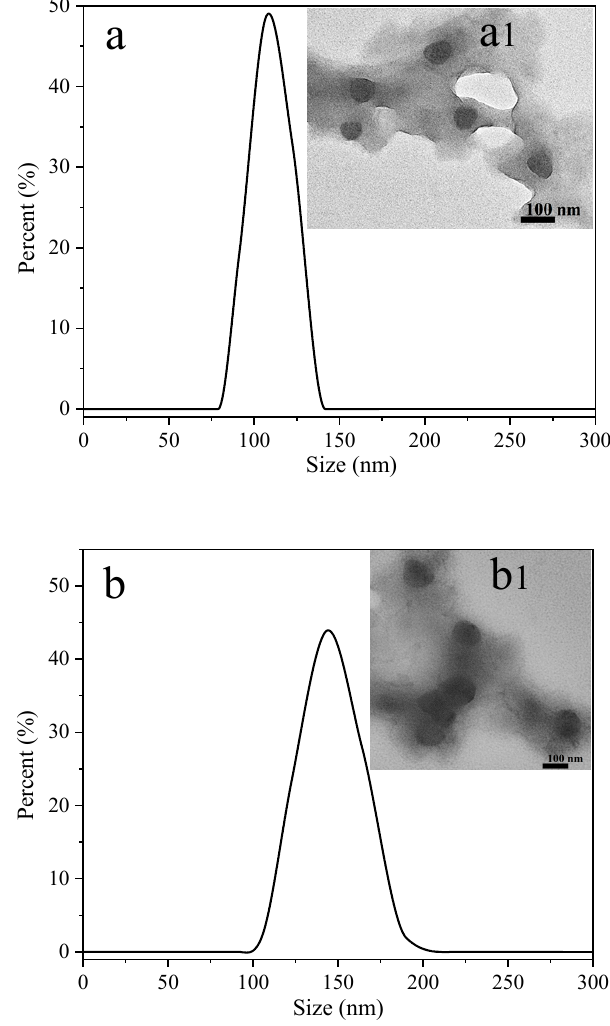
Figure 5. Size distributions of Eu-PMA-MPEG ( a ) and Eu/Tb-PMA-MPEG (Eu/Tb = 1:1) ( b ). TEM images of Eu-PMA-MPEG ( a1 ) and Eu/Tb-PMA-MPEG (Eu/Tb = 1:1) ( b1 ).